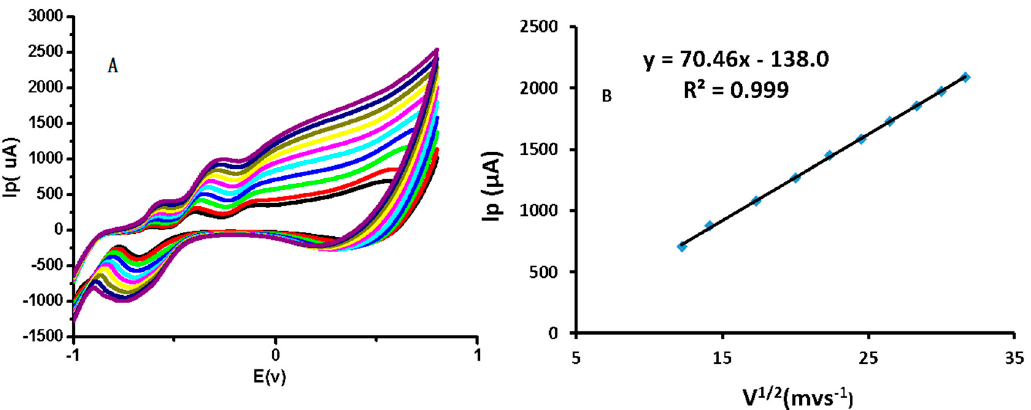
Figure 4. ( A ) Cyclic voltammograms obtained with CuO-nanostructure-modified GCEs in 0.1 M NaOH and 1 mM glucose at various scan rates (150, 200, 300, 400, 500, 600, 700, 800, 900 and 1000 mV · s − 1 ; ( B ) The inset shows the plot of Ip versus the square root of the scan rate.